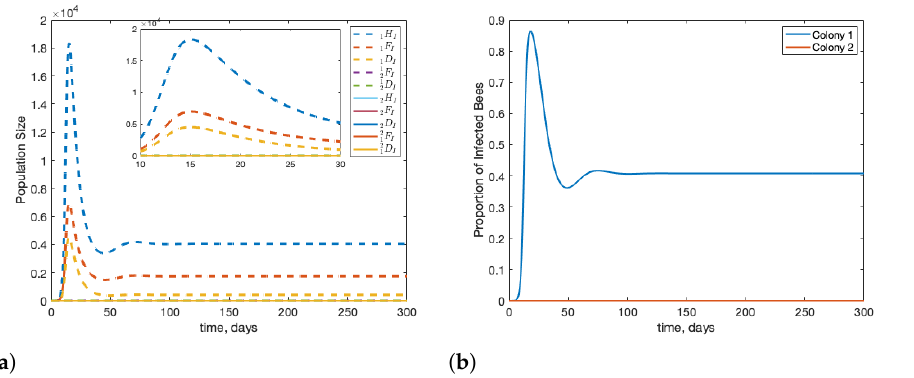
Figure 4. Beginning from equilibrium, we introduce one infected forager into colony 1 ( 1 F I ( 0 ) = 1). We see that infection is more severe and poses greater long-term risk when bees are not able to drift between colonies. Subfigure ( a ) shows the infected population in the hives, subfigure ( b ) shows the percentage of infected bees in each colony.